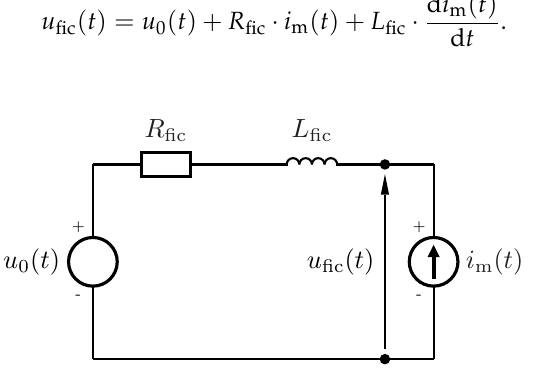
Figure 2. Fictitious grid implemented in Block 1 of the IEC 61400-21